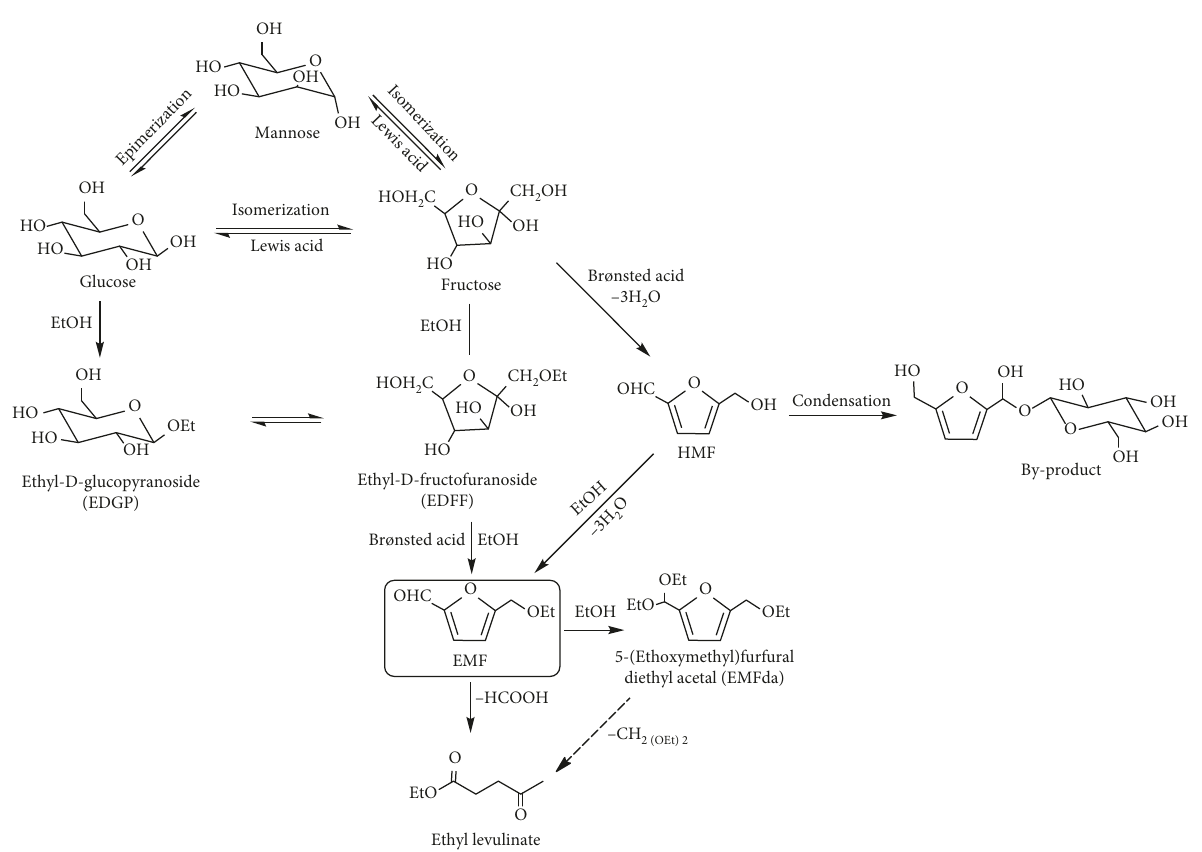
Scheme 2: Proposed mechanism for one-pot conversion of hexose to